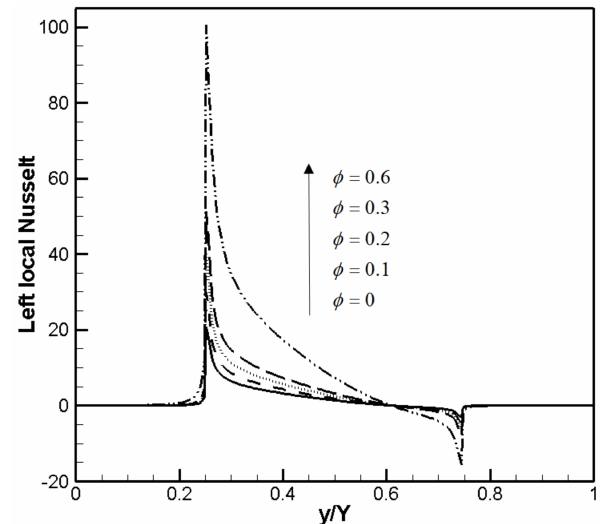
Figure 11. Variation of left local Nusselt number along the left boundary (Cu-water nanofluid) for different volume fraction φ (case 2: linear boundary condition) at Ra = 10 5